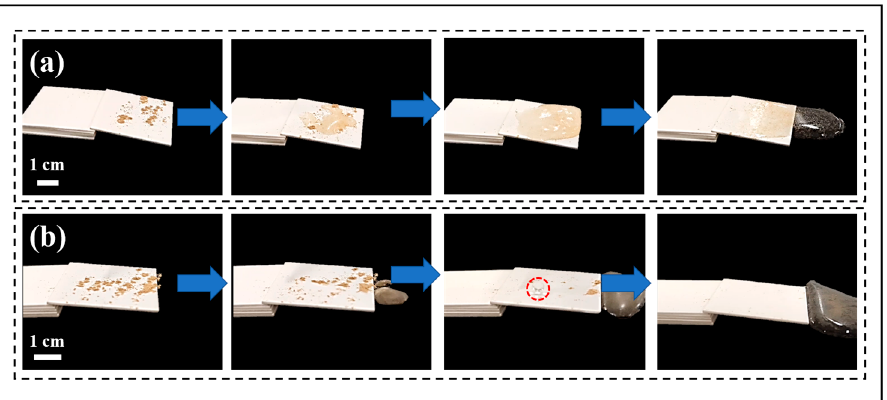
Figure 9. ( a ) Self-cleaning process of untreated sample; ( b ) Self-cleaning process of superhydrophobic sample.